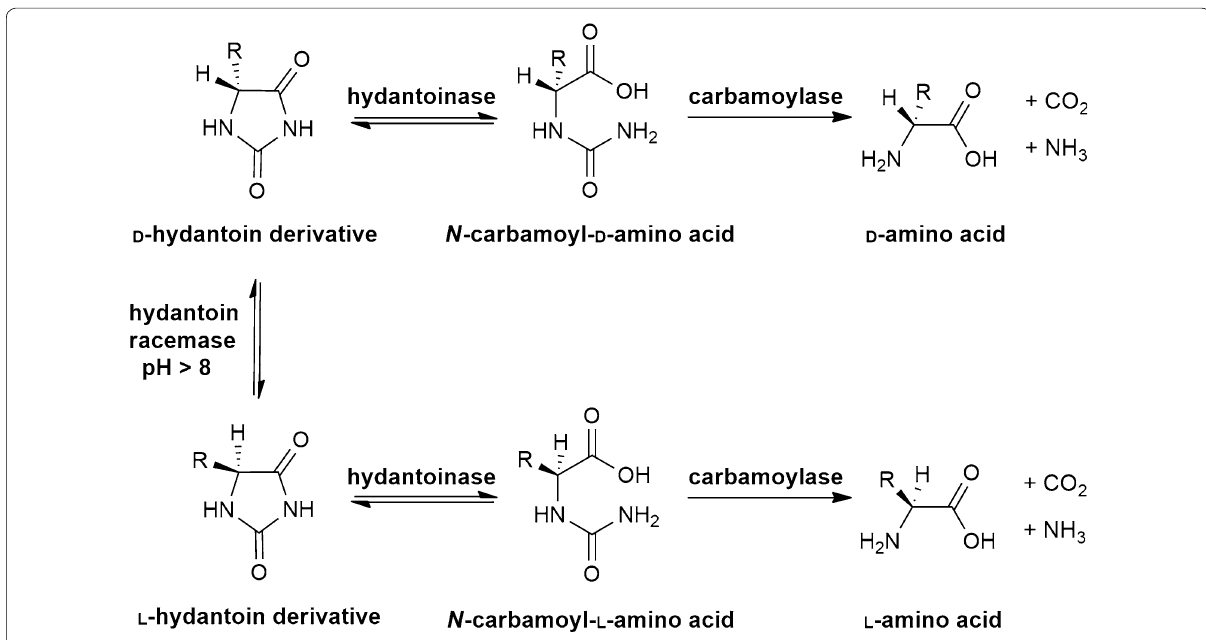
Fig. 1 Hydantoinase process for the synthesis of optically pure α-amino acids starting from racemic 5-monosubstituted hydantoins [Modified after Syldatk et al.